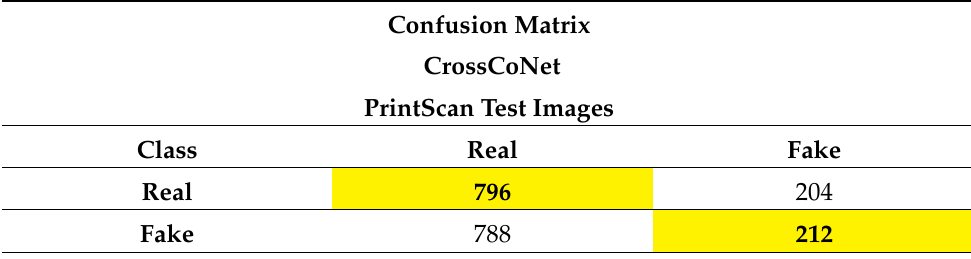
Table 8. Confusion matrix of CROSSCONET for printed and scanned GAN-image